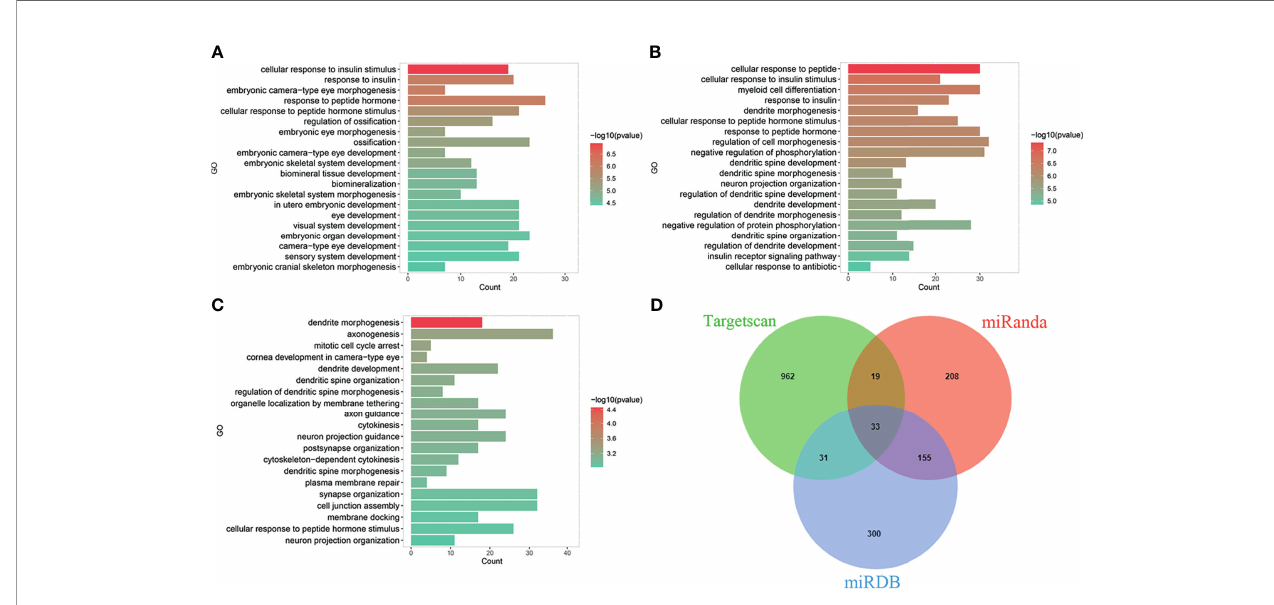
FIGURE 1 | Biological function prediction of miR-223 target genes. Functions of miR-223 target genes analyzed in TargetScan database (A) , miRDB database (B) , and miRanda database (C) . (D) The intersecting target genes of the three